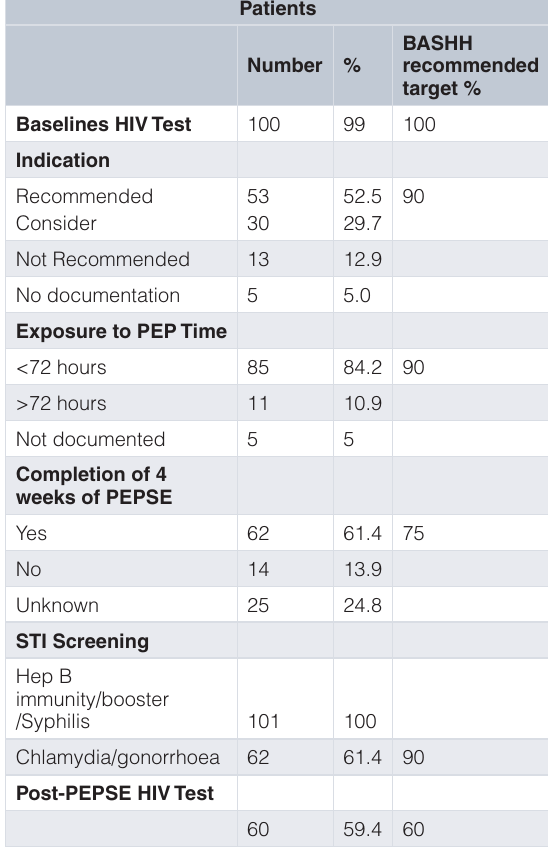
Table 1. Auditable targets for prophylaxis for human immunodeficiency virus (HIV) following sexual exposure.